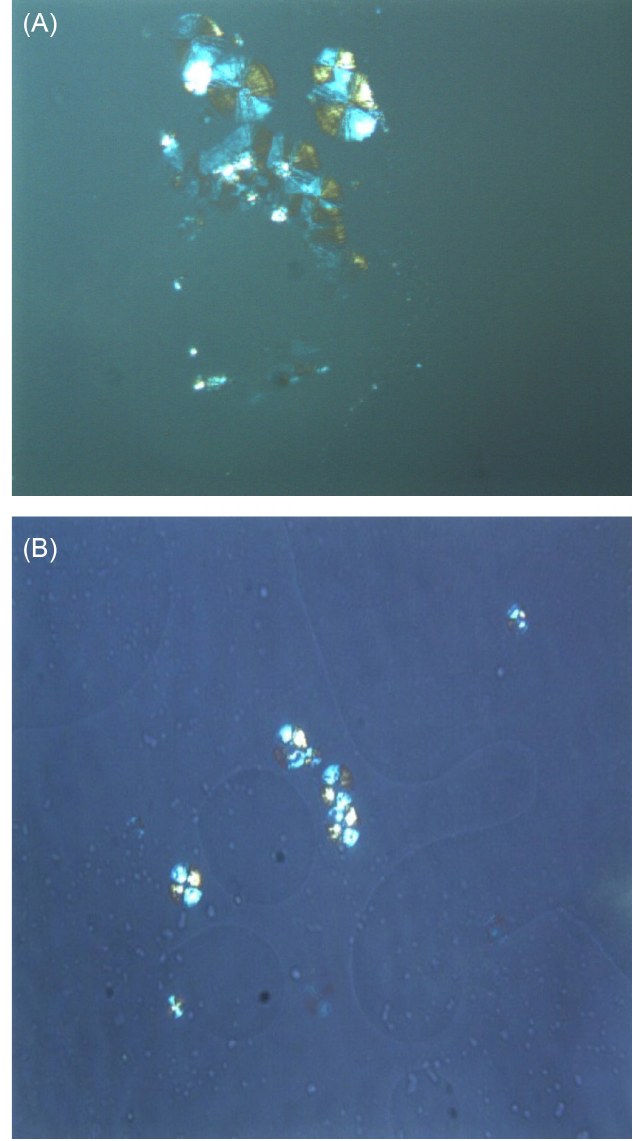
FIGURE 2 - Photomicrographs of samples by polarized light microscopy, where: (A) transparent liquid system and (B) transparent viscous